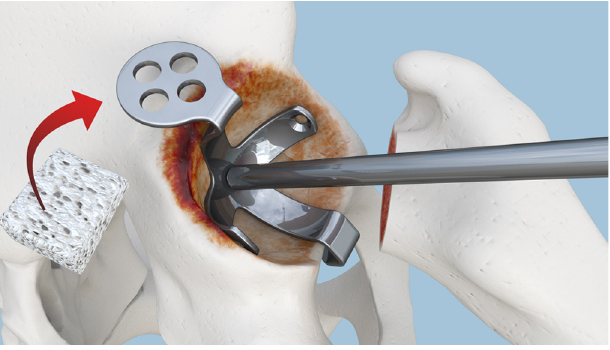
Figure 5. The gap is fi lled with a graft. Upper view.